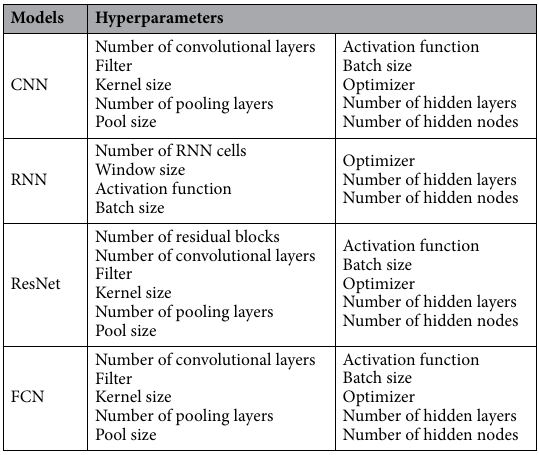
Table 3. Hyperparameter tuning of each model.